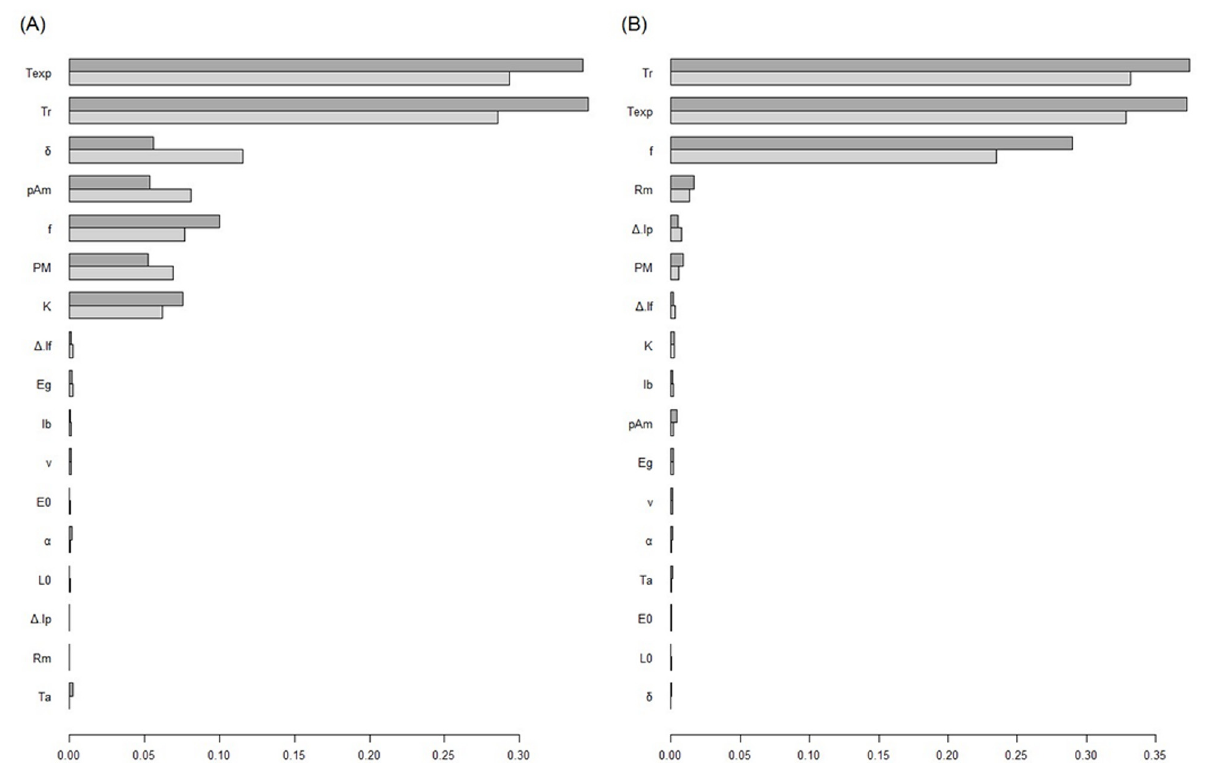
Fig 2. Mean of the DEB model sensitivity analysis results for length equations (A) and reproduction equations (B). Parameters are ordered according to the Sobol ’ s first order indices (light gray). Dark gray indices are the Sobol ’ s total indices. First order (Si) and total Sobol ’ sensitivity indices (STi) were estimated at 25, 50, 75, 100, 200, and 400 dpf for length prediction and at 100, 200, and 400 dpf for the reproduction